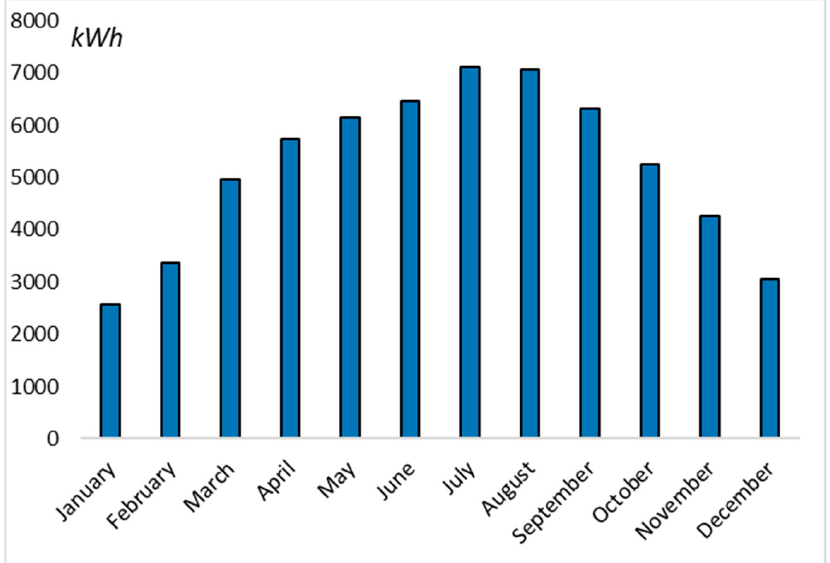
Figure 7. Distribution of the facility’s total generation over the year.